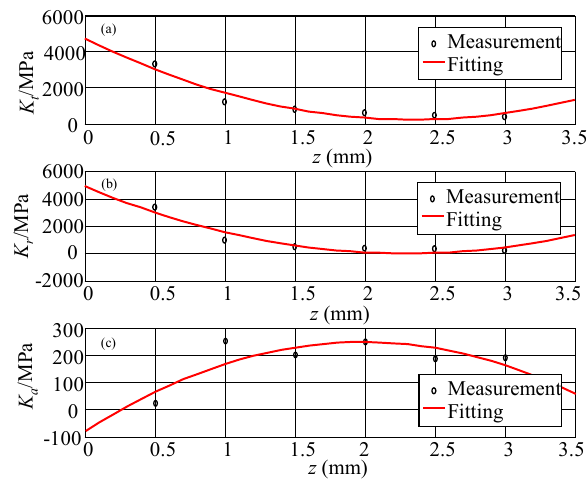
Figure 5. Cutting force coefficients of cutter layer with different axial heights: ( a ) K t ; ( b ) K r ; ( c ) K a .